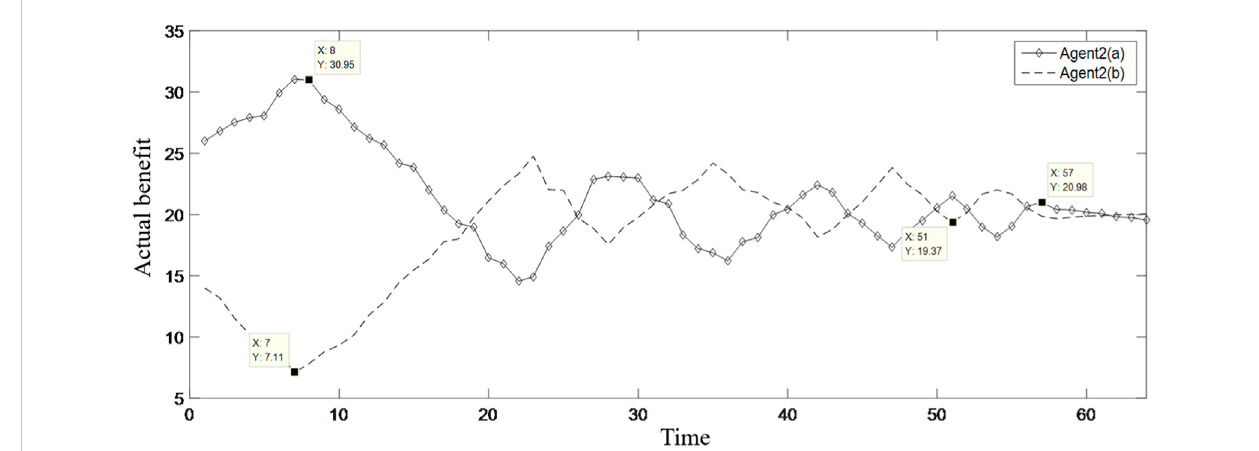
FIGURE 4 Changes in the bene fi ts of Agent 2.